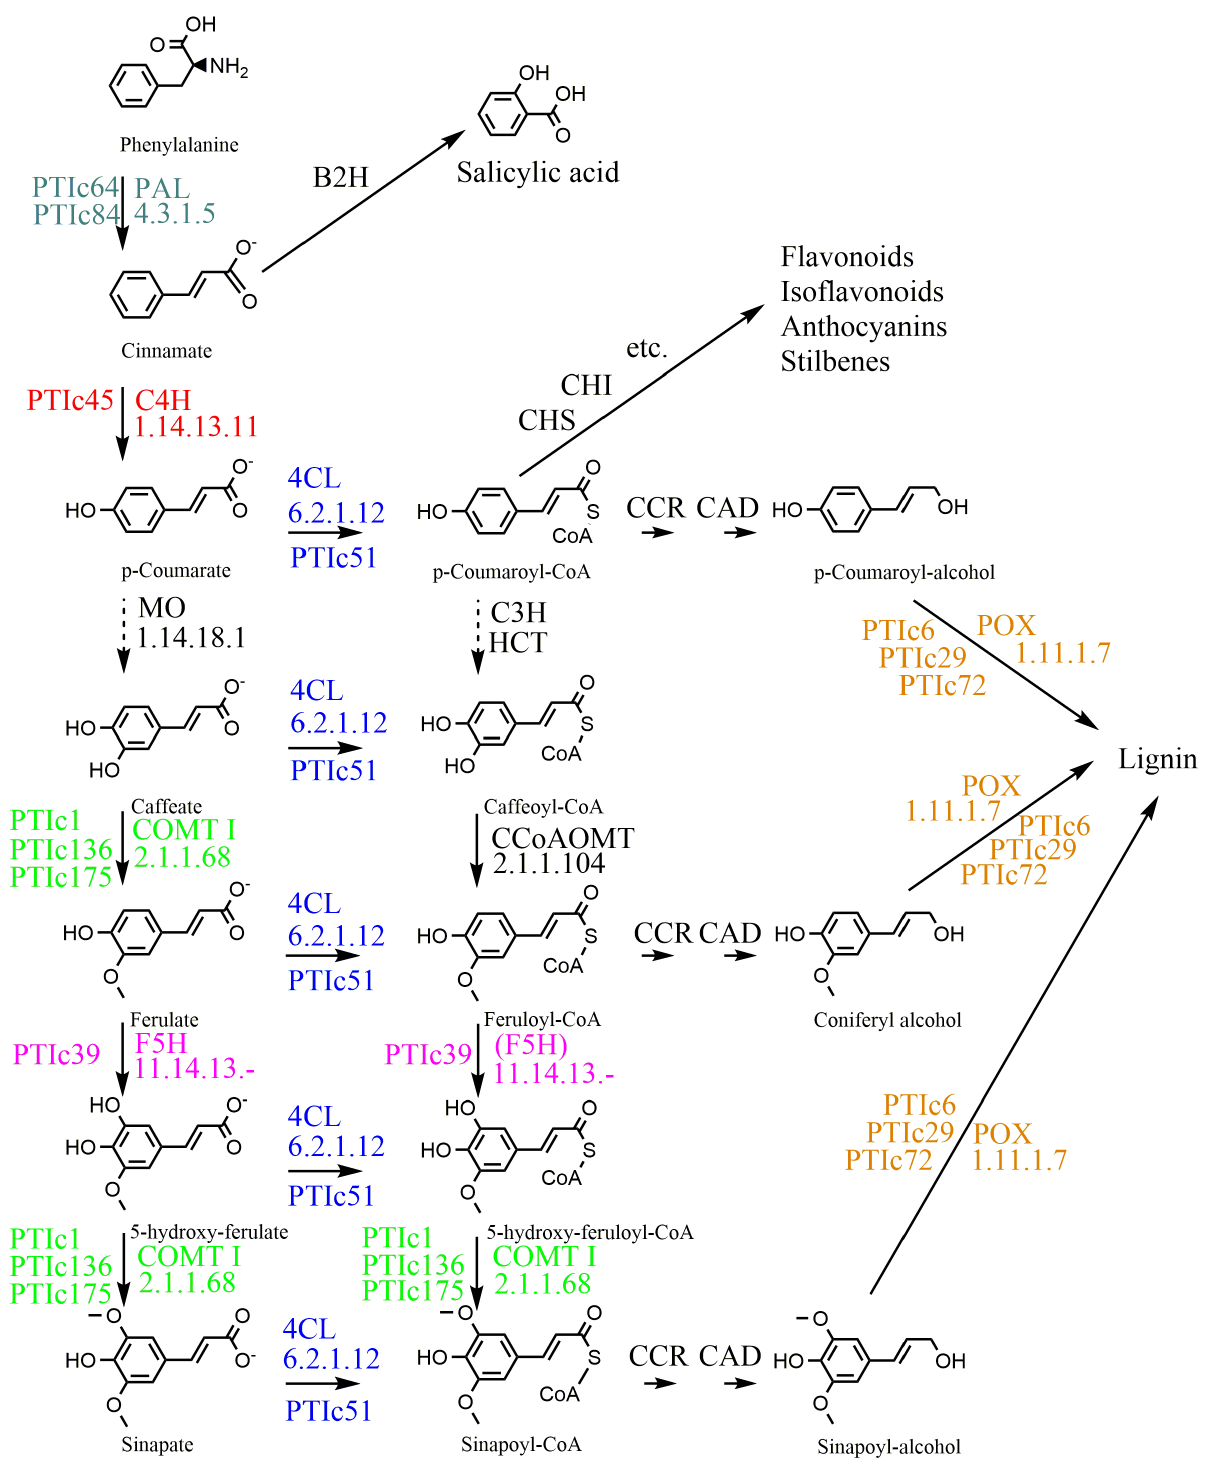
Figure 4. A current view of the phenylpropanoid metabolism. Colours indicate the enzymes found in our PTI cDNA library. Each colour corresponds to a specific type of enzyme. Numbers of contigs, and KEGG codes of each enzyme are indicated (Kyoto Encyclopedia of Genes and Genomes http://www.genome.ad.jp/kegg/). Dashed arrows indicate that the process mechanism of the given enzymatic reaction is not known. Abbreviations: PAL, Phenilalanine ammonia-lyase; C4H, cinnamate 4-hydroxylase; MO, monophenol oxidase; COMT I, caffeic/5-hydroxyferulic acid O- methyltransferase; F5H, ferulate 5-hydroxylase; 4CL, 4-hydroxycinnamoyl-CoA ligase; C3H, p-coumarate 3-hydroxylase; HCT, hydroxycinnamoyl- transferase; CCoAOMT, caffeoyl-CoA O-methyltransferase; CCR, cinnamoyl-CoA reductase; CAD, cinnamyl-alcohol dehydrogenase; POX, peroxidase; CHS, chalcone-synthase, CHI, chalchone-isomerase; B2H, benzoic acid-2-hydroxylase. (Based on [54])